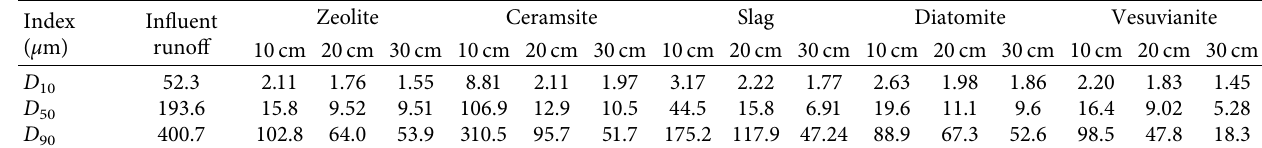
Table 2: Typical diameter indices of runoff through filter media with different layer